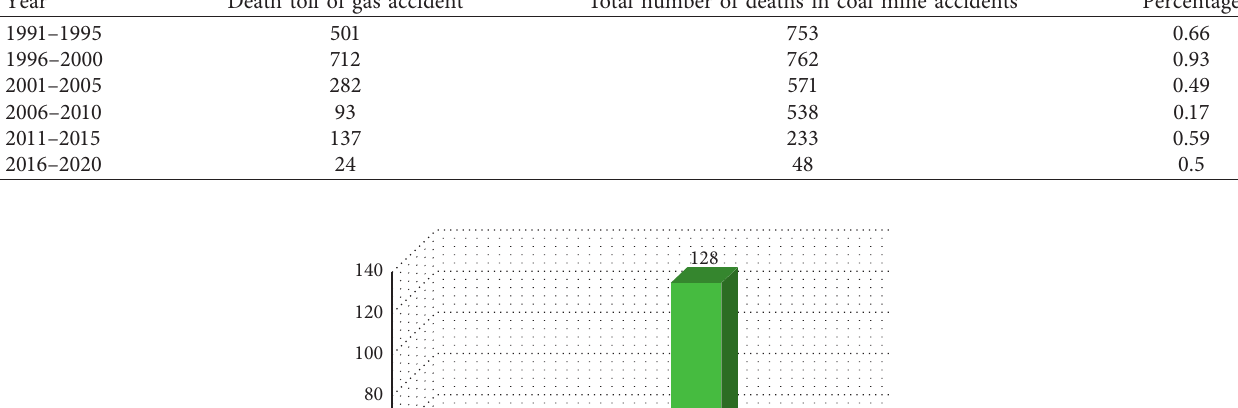
Year Death toll of gas accident